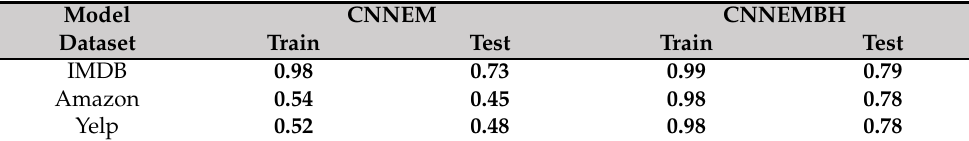
Table 10. A comparison of the accuracy of the two in-depth models.